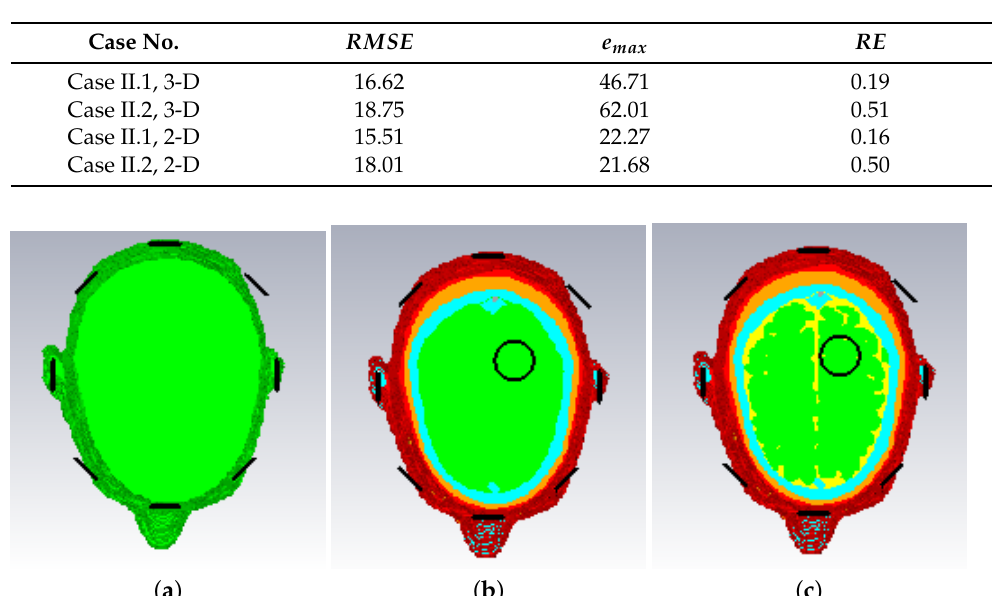
Table 4. Reconstruction errors for the cases considered in Section 3.2.1.